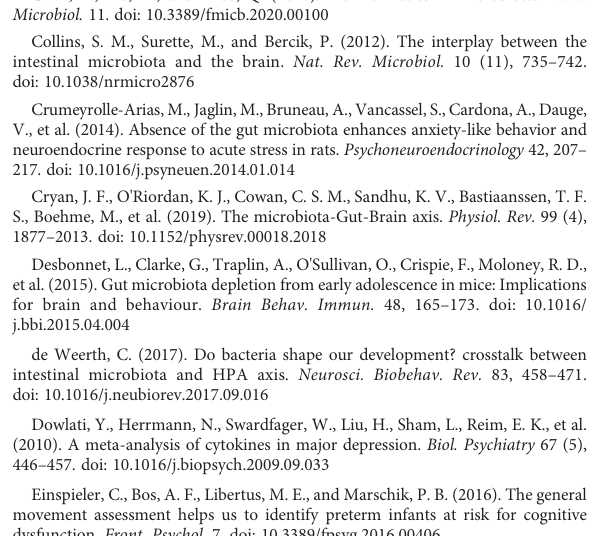
micro fl ora at the order, family, and genus levels in the two groups.